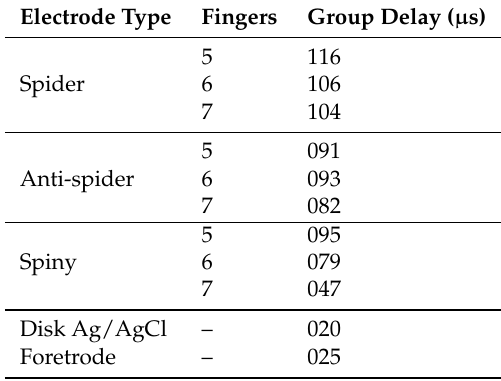
Table 2. Mean group delay for the different